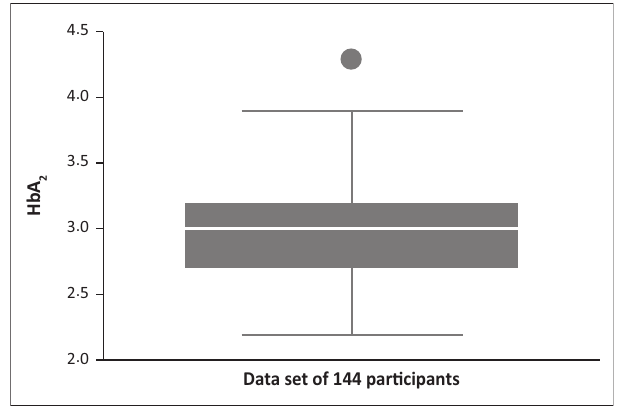
FIGURE 2: Box-plot of haemoglobin A October 2012 – 31 December 2020.